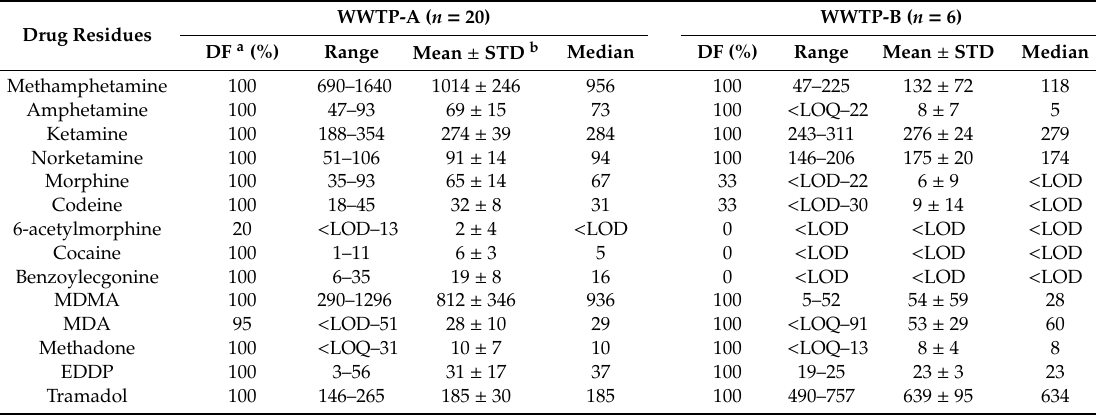
Table 1. Statistics of drug residue concentrations (ng / L) in wastewater treatment plant (WWTP)-A and -B.